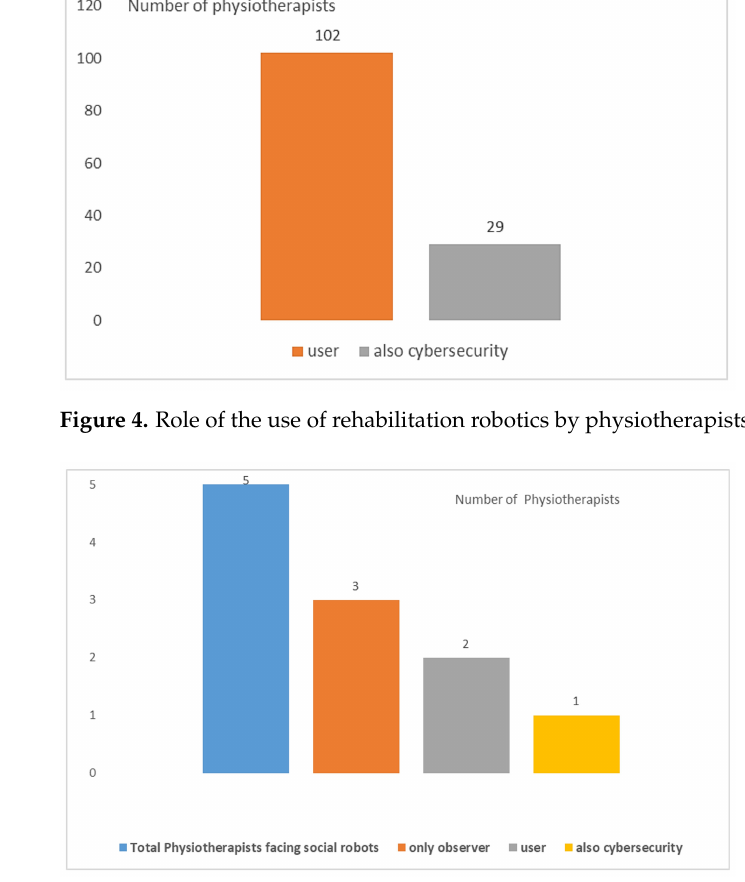
Figure 5. Physiotherapists’ interaction with social robots. Table 3. Perceived degree of training on SRs, robots for BA, robots for LOLI, robots for UPLI. Question Mean CI 95% Upper limb rehabilitation 4.55 ± 0.38 Lower limb rehabilitation 4.43 ± 0.37 Balance 4.42 ± 0.38 Social robot 3.63 ± 0.38